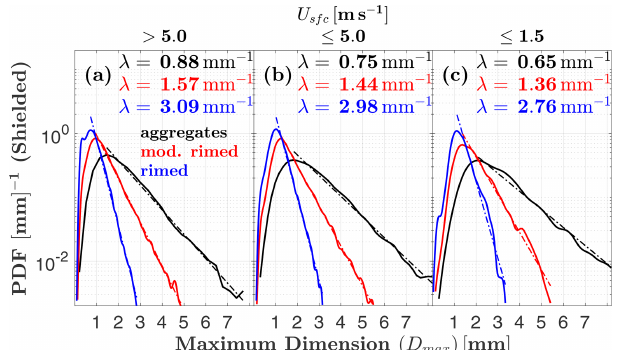
Figure 10. As in Fig. 9 but with hydrometeors divided into three riming degree categories: sparsely rimed aggregates, moderately rimed, and rimed. Only shielded MASC measurements are shown.